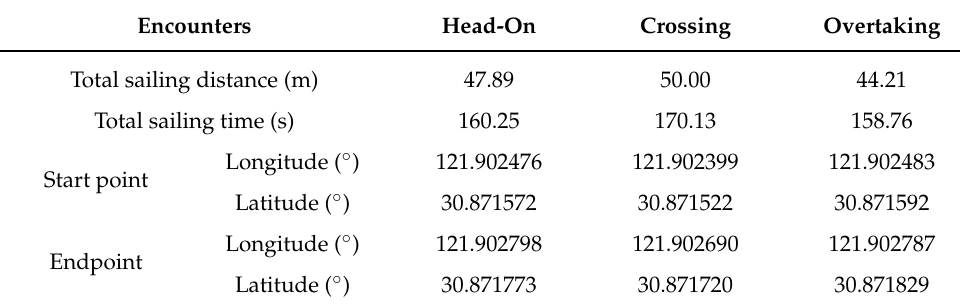
Table 8. USV’s navigation trajectory data.